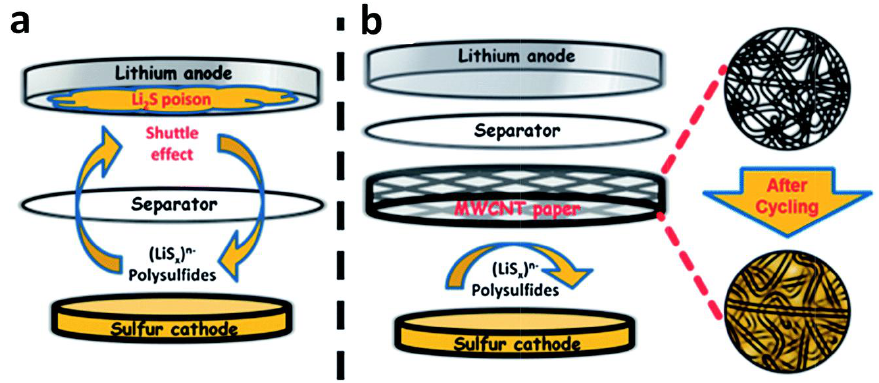
Figure 2. The schematic arrangement of Li–S cell: ( a ) Traditional arrangement with severe shuttle effect and Li 2 S poison problems; ( b ) new arrangement with the multi-walled carbon nanotube (MWCNT) interlayer. Taken from [52].